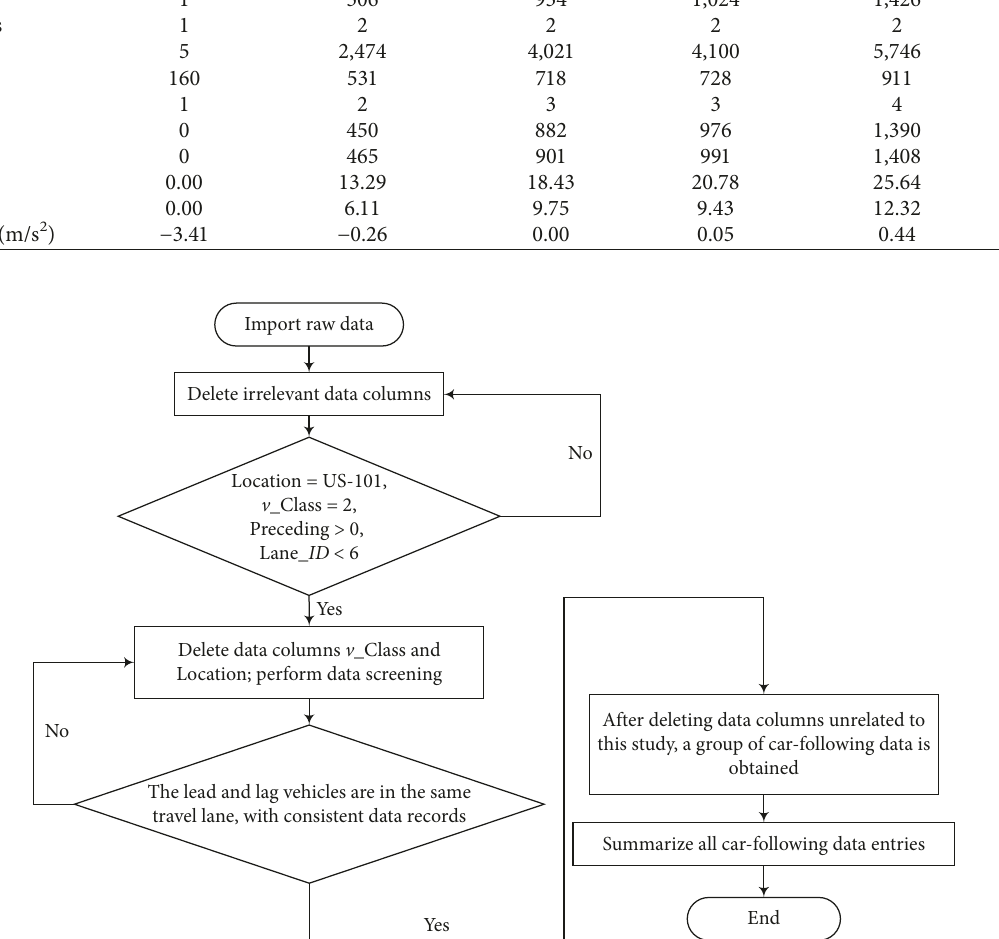
Figure 1: Car-following data screening